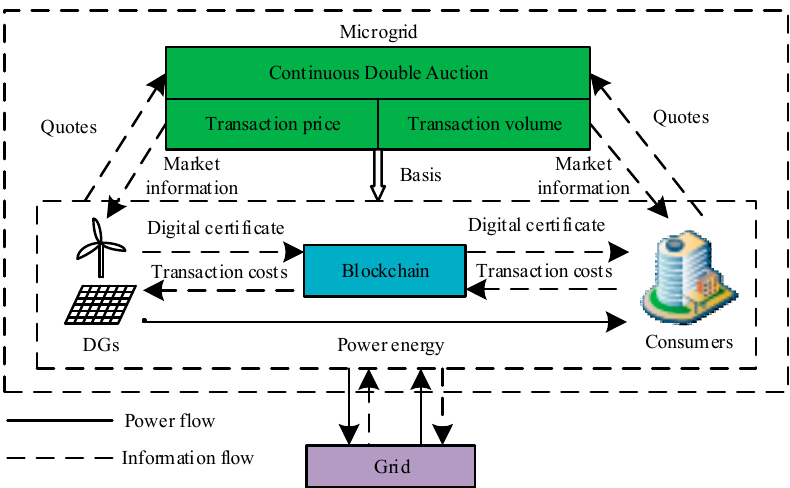
Figure 4. Overall structure of microgrid electricity transactions.